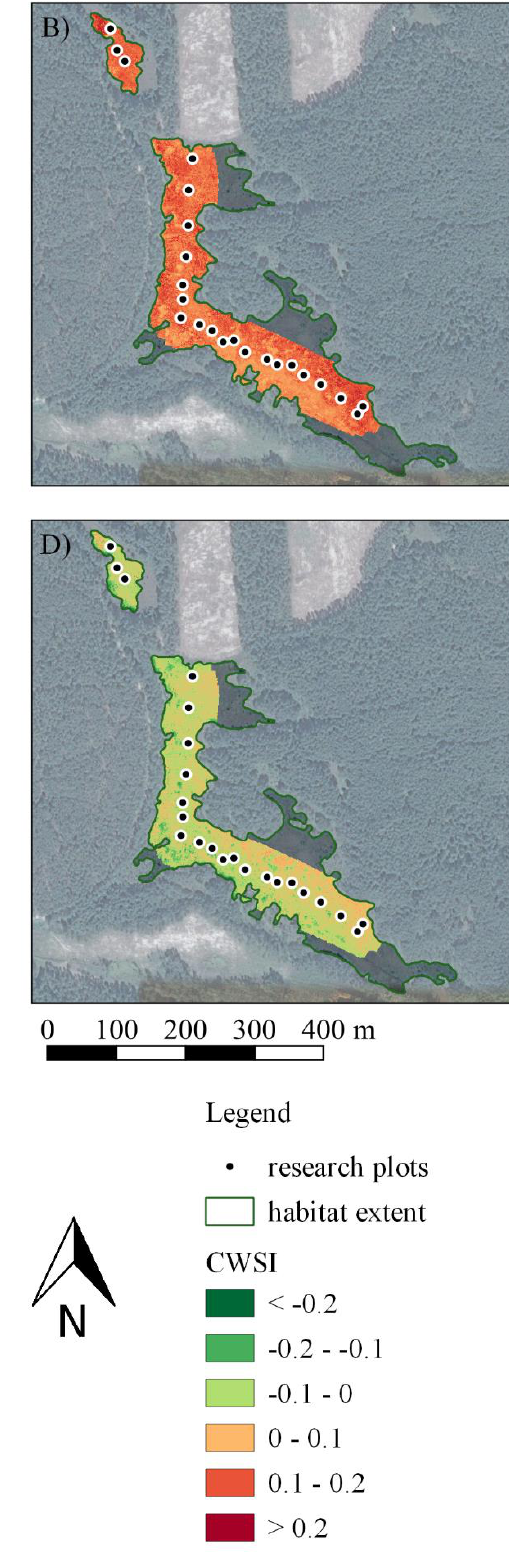
Figure 4. The spatial distribution of CWSI with the location of research plots in the Janów Forest Landscape Park for 5 UAS campaigns in 2017: ( A ) 14 July, ( B ) 1 August, ( C ) 19 August, ( D ) 30 August, and ( E ) 9 September.